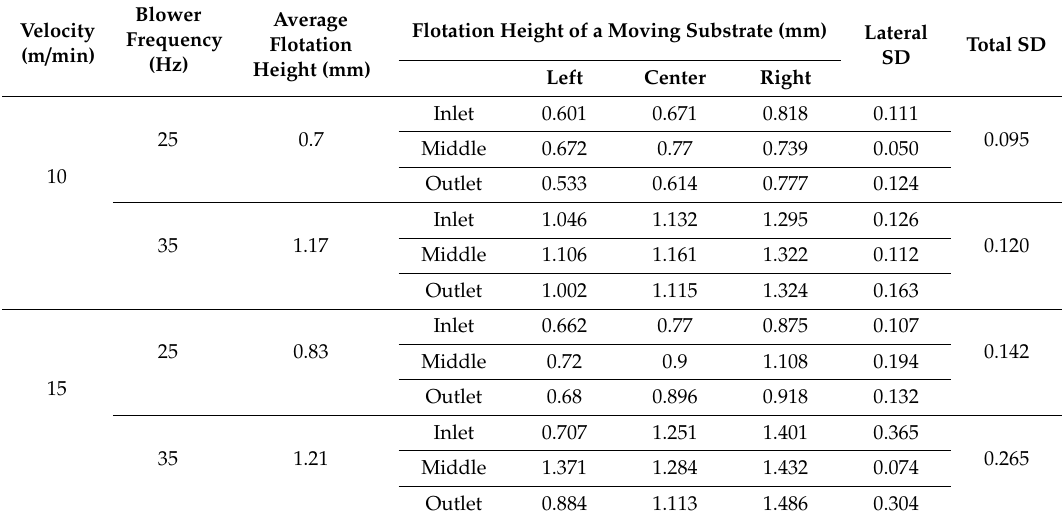
Figure 9. Measured flotation heights as a function of operating velocity and blower frequency. A width of 0 mm refers to the right area and a wrap angle of 0 degrees refers to the inlet. The velocity